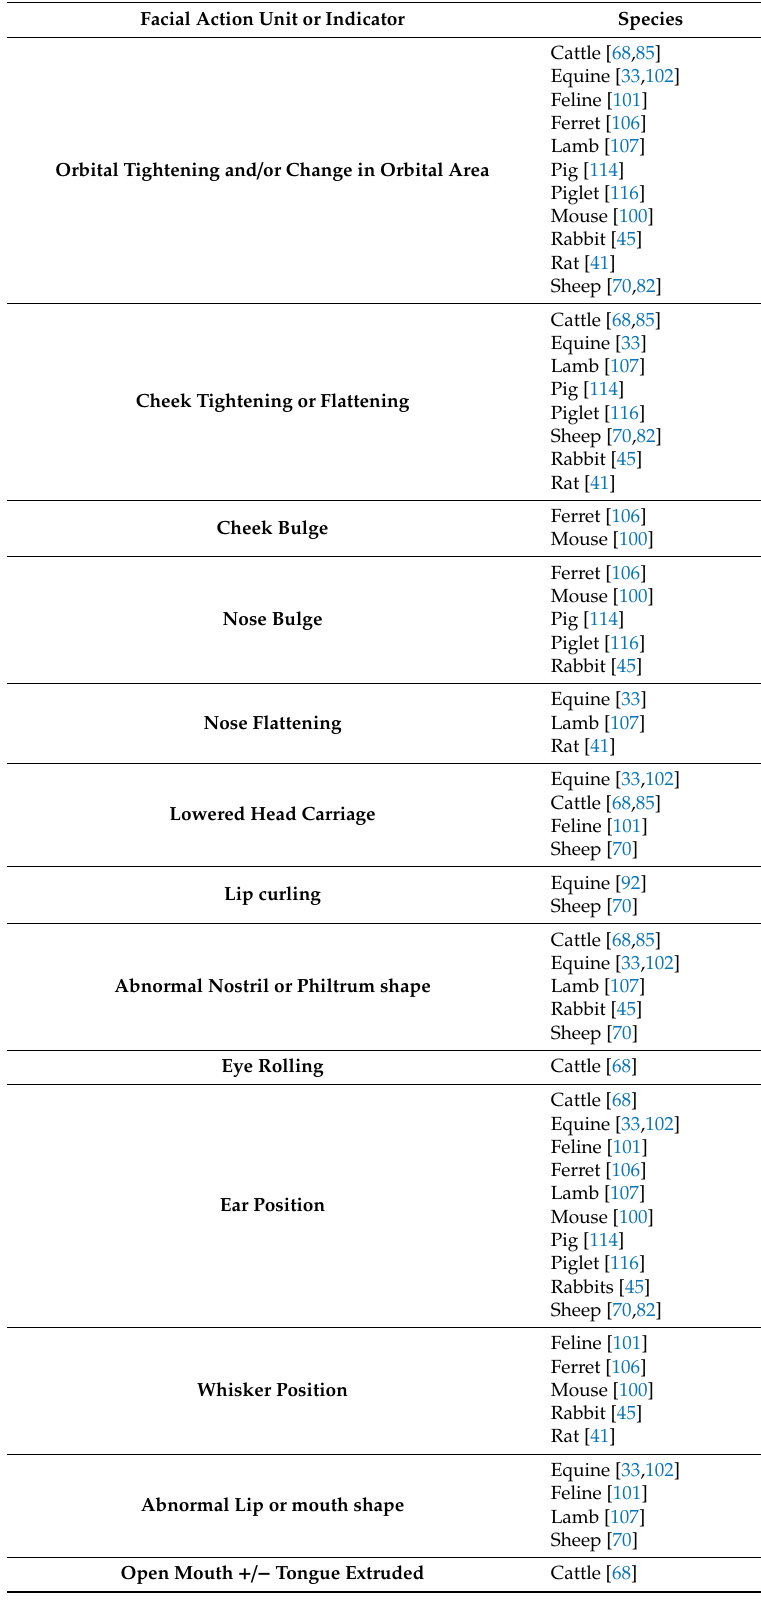
Table 3. Grimaces Scales Facial Action Units by